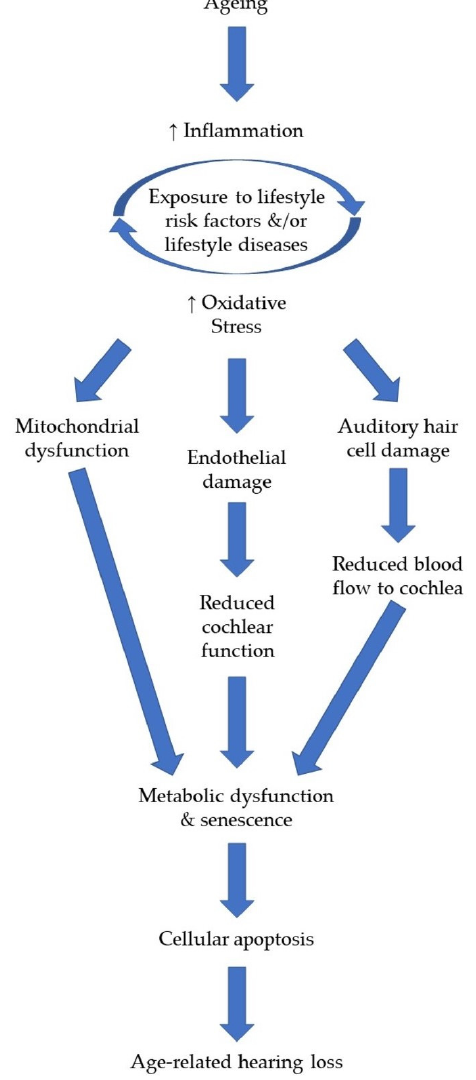
Figure 1. Flowchart of the role of lifestyle risk factors and oxidative stress in ARHL. This figure describes the association between lifestyle risk factors and oxidative stress in ARHL. The proposed mechanism of action relates to dysfunction of the mitochondria, damage to the endothelium and auditory hair cells, leading to apoptosis of auditory cells. ↑ indicates increasing.